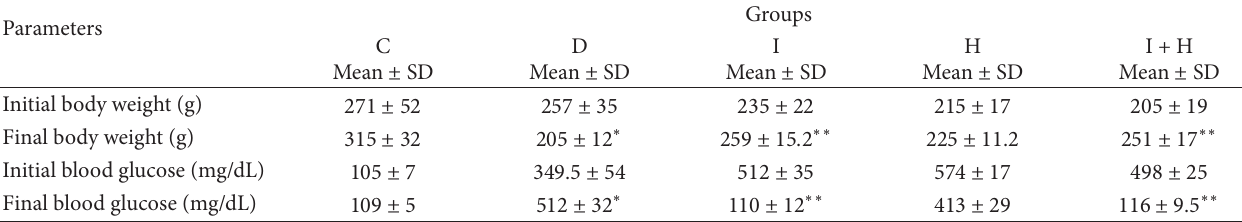
Table 1: Characteristic parameters of the control and STZ-diabetic rats.